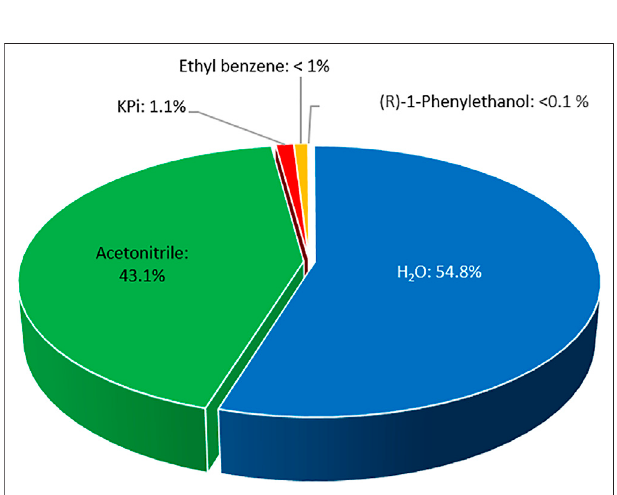
FIGURE 6 | Hydroxylation of ethylbenzene to ( R )-1-phenylethanol in presence of 50 vol% acetonitrile in 100 mL scale. Reaction conditions: 300 mM substrate concentration, 100 mM potassium phosphate buffer, pH 6.0, 10 µM r Aae UPO (concentrated supernatant), and H 2 O 2 -dosing rate: 50 mM h − 1 . The reaction was stirred at 300 rpm at 25 ° C. The concentration of all analytes derived from calibration curves. GC-analysis was performed on the chiral column (CP-Chirasil-Dex